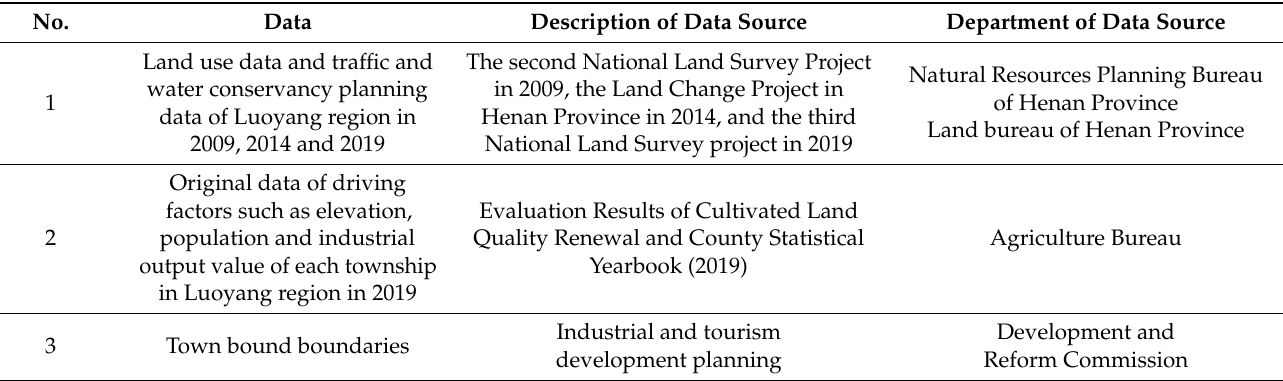
Table 1. Description of data sources.